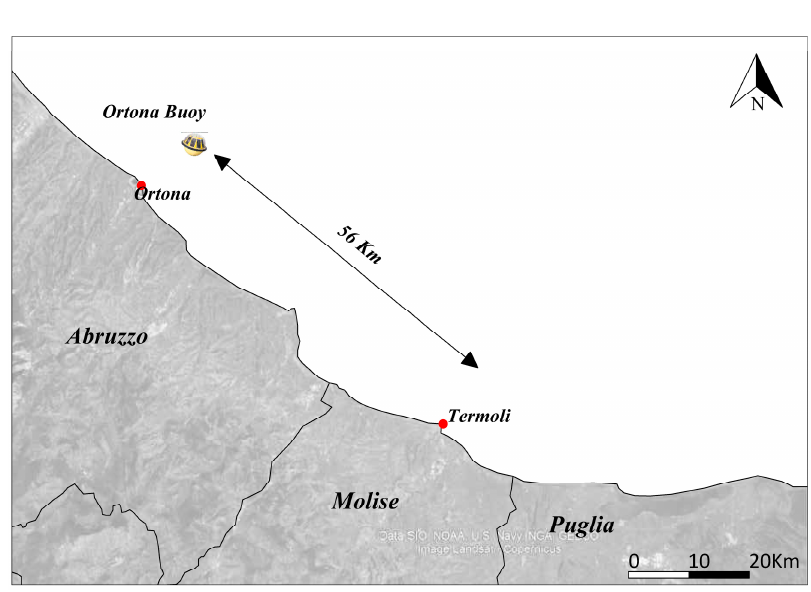
Figure 4. Localization of the Ortona wave buoy.